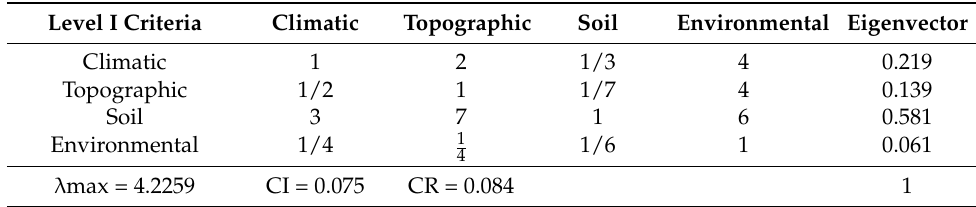
Table 3. Pair-wise comparison matrix of criteria.